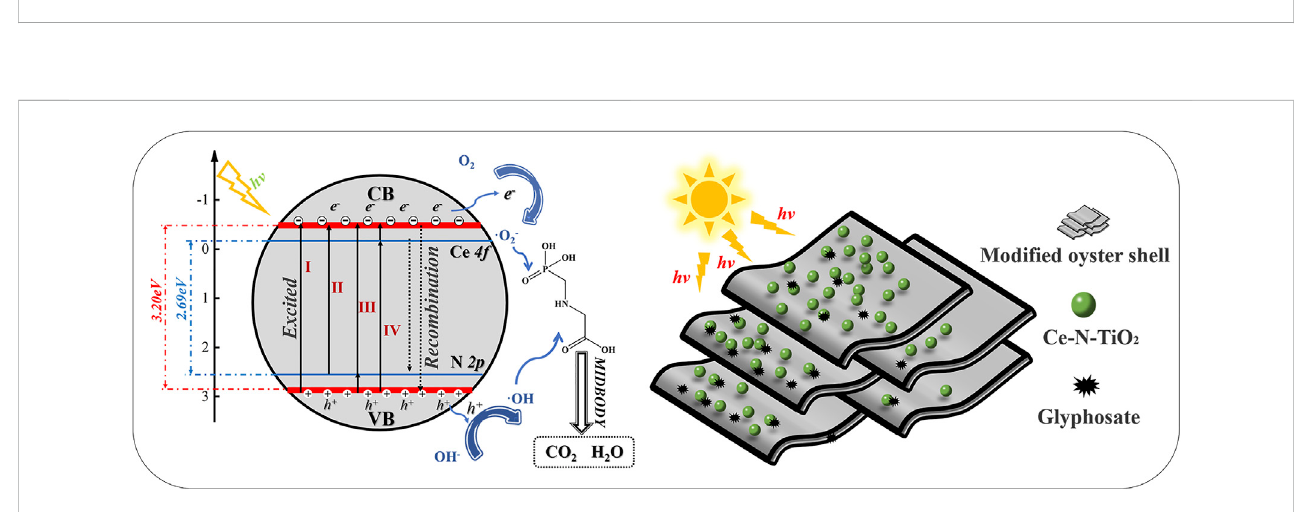
FIGURE 9 EffectsofdifferentscavengersonphotocatalyticdegradationofPMG (A) ;EPRspectrarecordedinthedarkandvisiblelightwith1min,5minand10minof 0.5%-CeNT@TiO 2 photocatalyst (B) and (C) .